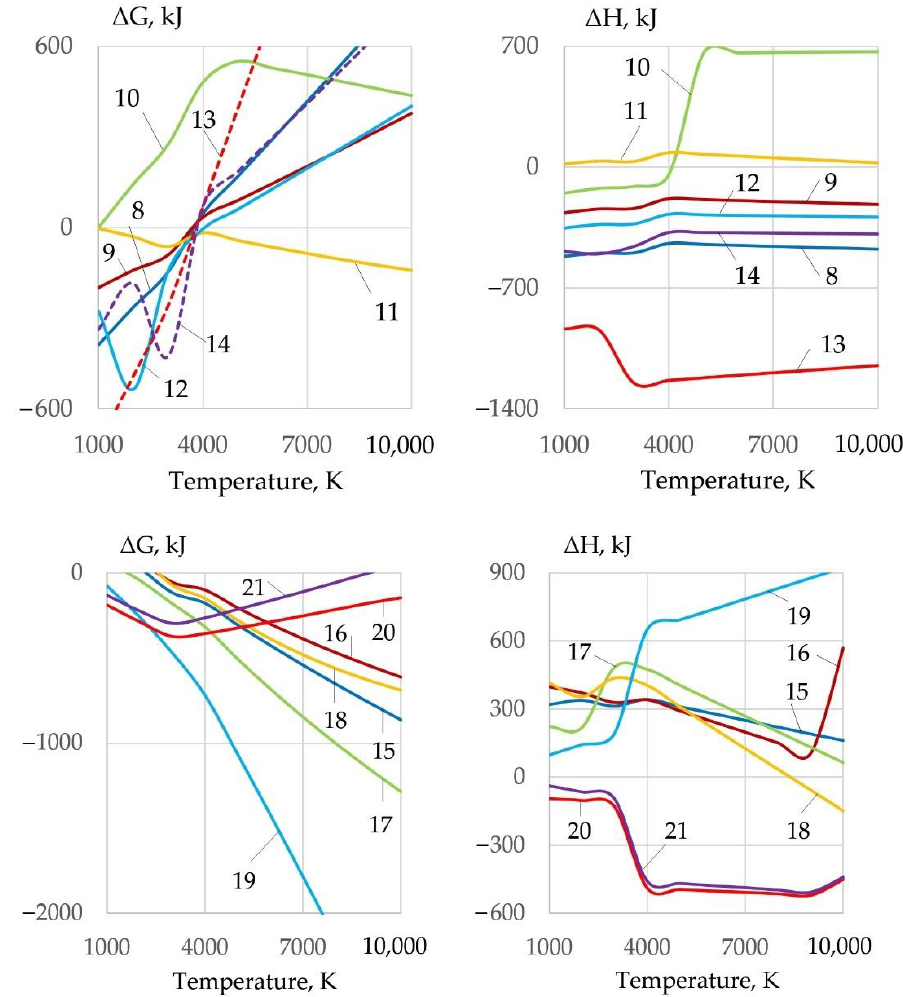
Figure 7. Change of Gibbs free energy and enthalpy of iron oxidation reactions ( 8 )–( 21 ) in interaction with gases and salts.